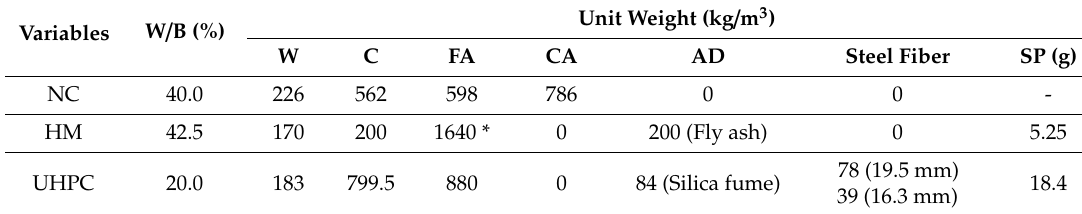
Table 3. Mix designs of